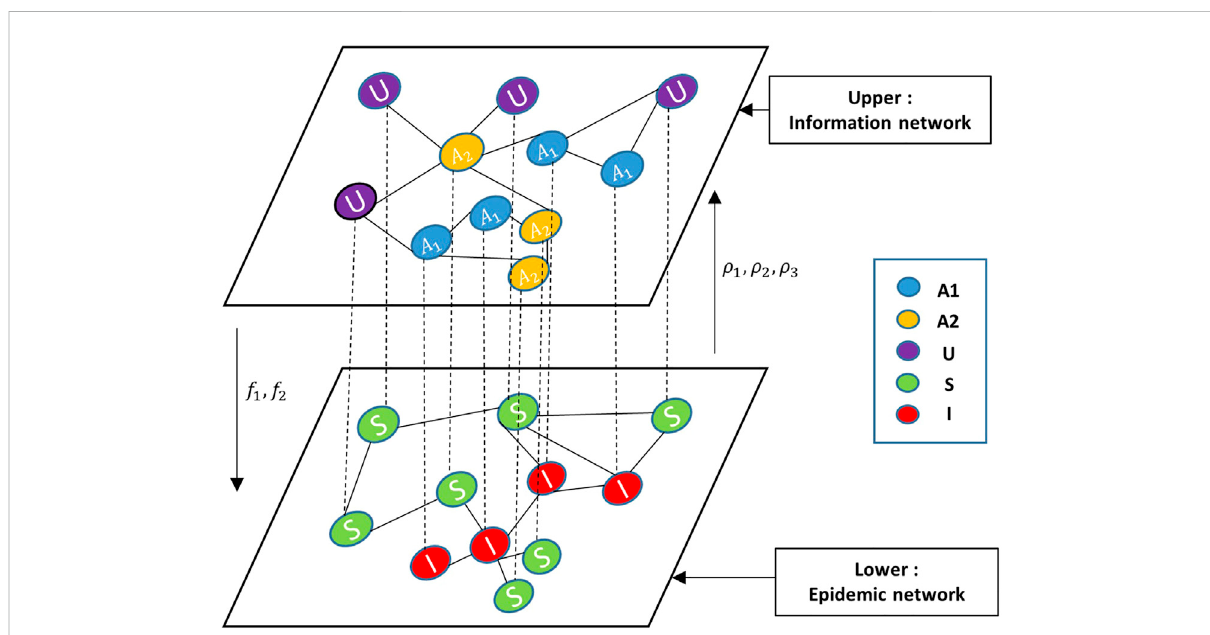
FIGURE 1 Structure of the individual-based epidemics and multi-type information spreading model (IEMIS) in a two-layered network. Nodes in the information network (the upper layer) have three possible states: unaware( U ), aware of positive prevention ( A 1 ), or aware of negative prevention ( A 2 ). Nodes inthe epidemic network (the lower layer) have two possible states: susceptible (S) or infected (I). The description of key parameters is listed in Table